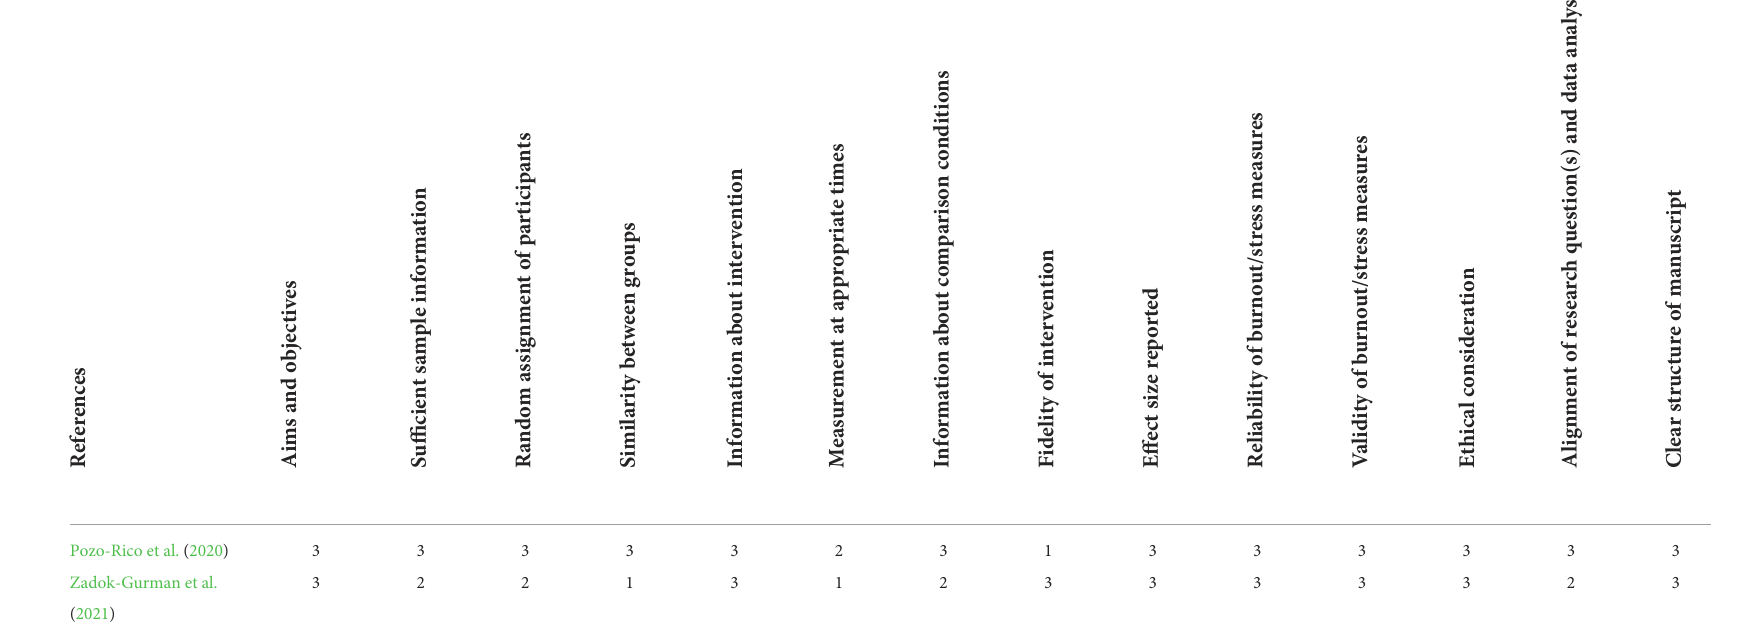
TABLE 4 Quality ratings of intervention studies included in the